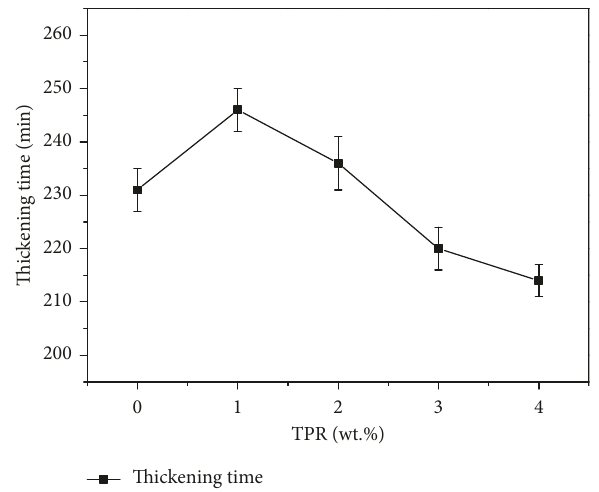
Figure 7: Thickening time of cement slurry with different modified TPR